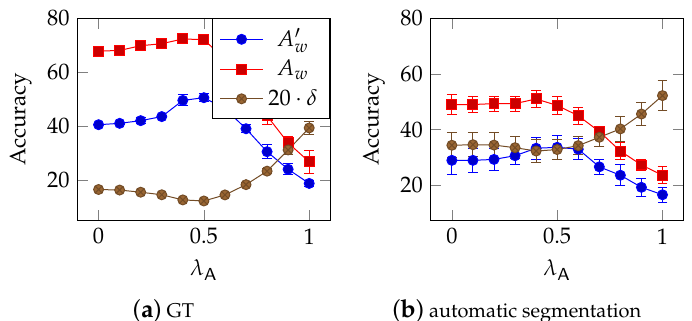
Figure 12. Optimization of the weight λ A of character level apriori information P ( Y rankings (see Equation (6)). ( a ) As expected, best results are achieved for λ A of about 0.5. However, as